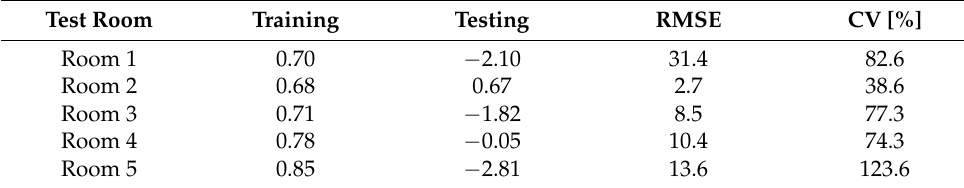
Table 3. Linear regression results using room data